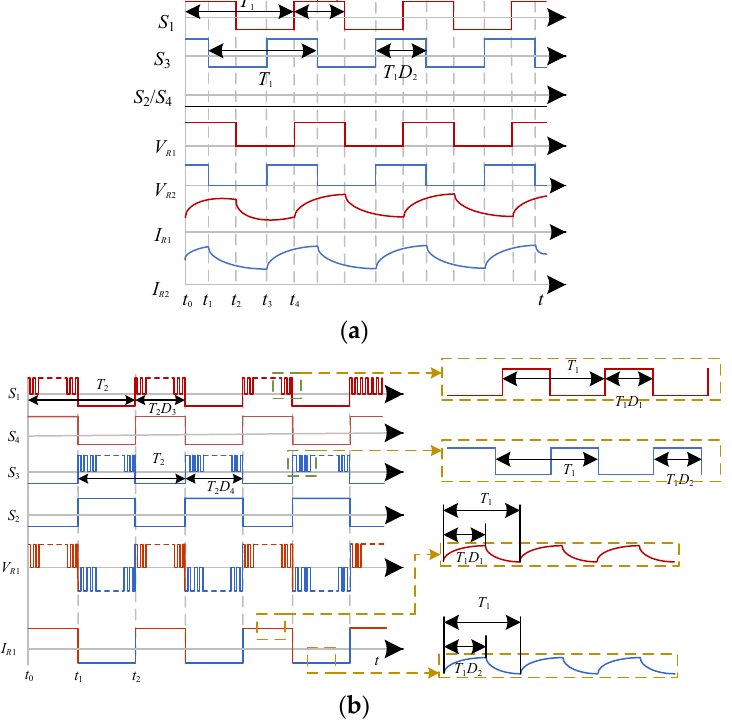
Figure 4. Principle of converter. ( a ) Principle of DC mode, ( b ) Principle of AC mode. In the welding process, an inductor is used in the converter to maintain a stable